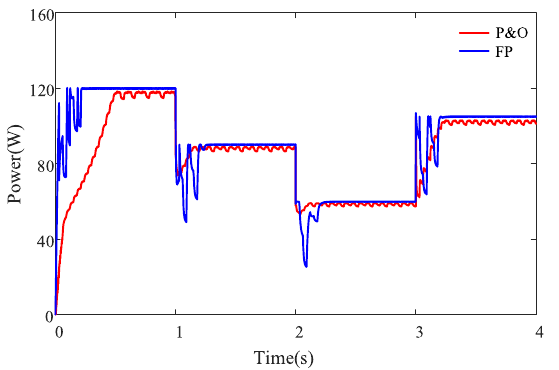
Fig. 6 Response of P&O and the proposed algorithm under